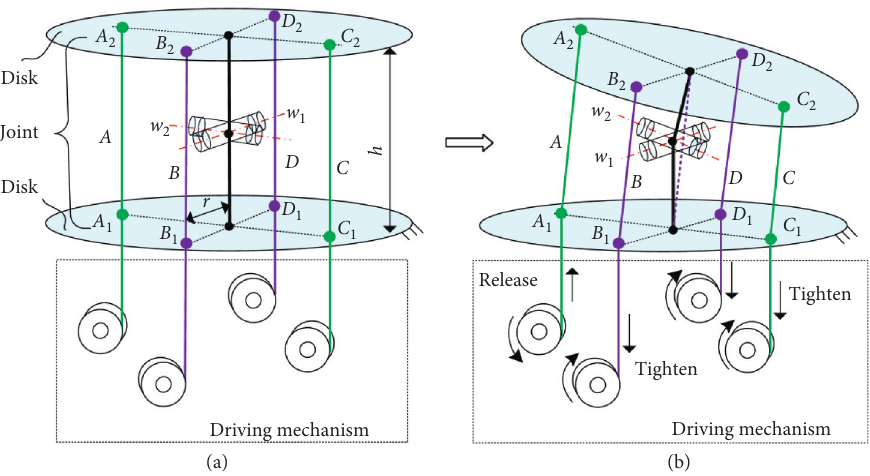
Figure 1: The traditional universal joint with two intersecting rotation axes.